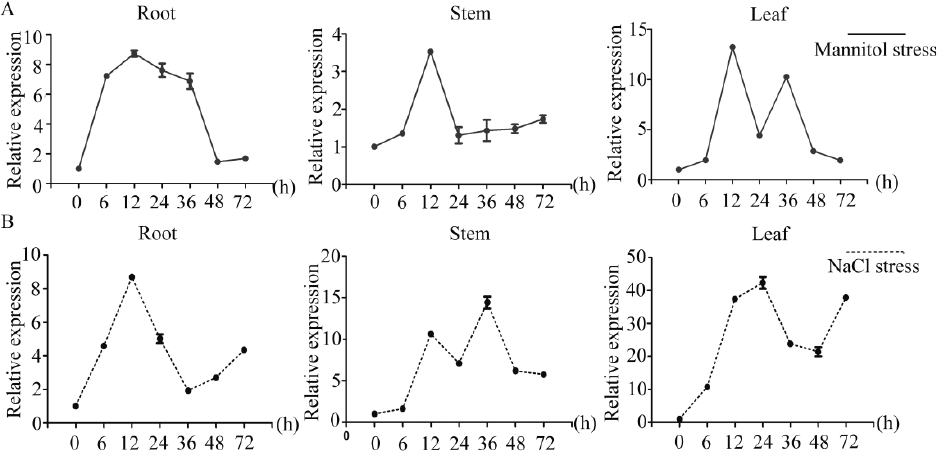
Figure 3. Expression patterns of the PtrDHN -3 gene in root, stem and leaf samples from P. trichocarpa sampled at 0, 6, 12, 24, 48, and 72 h. Time-course expression patterns of PtrDHN-3 in response to ( A ) mannitol stress. ( B ) NaCl stress. Expression under control conditions was assigned a value of 1, and then expression under stress treatment was normalized to this level. Error bars indicate ± SD, and each data point represents the mean of three replicate experiments.